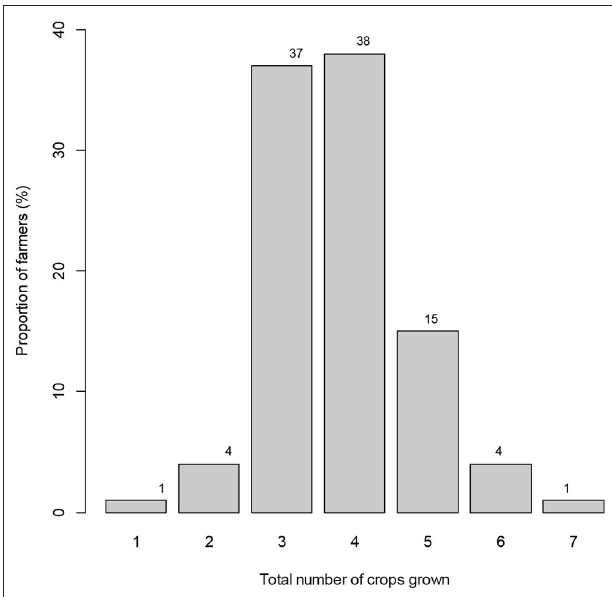
FIGURE 4 | Proportion of farmers interviewed ( n = 202) in Makueni County growing different numbers of crop species annually on their farm.